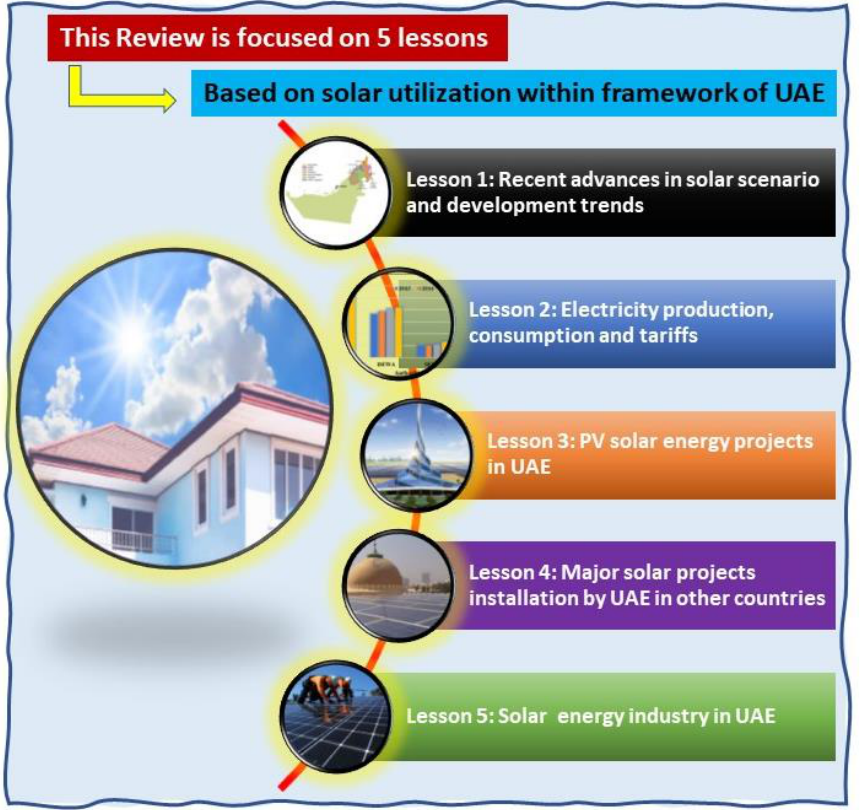
Figure 3. The layout of this review.